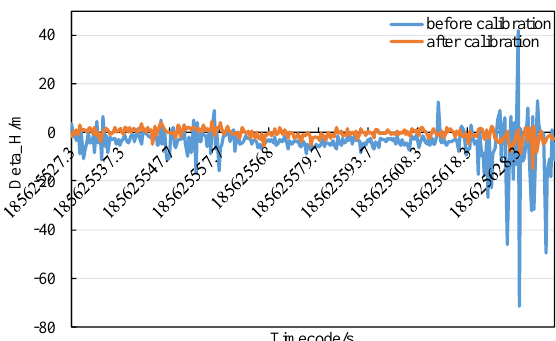
Figure 8. Elevation difference of the 246 th track laser